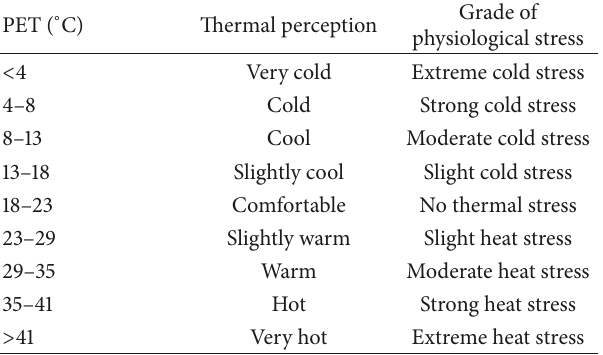
Table 1: Ranges of physiologically equivalent temperature (PET in ∘ C) for different grades of thermal perception by humans according to Matzarakis and Mayer [30] with internal heat production, 80 W, and heat transfer resistance of the clothing, 0.9